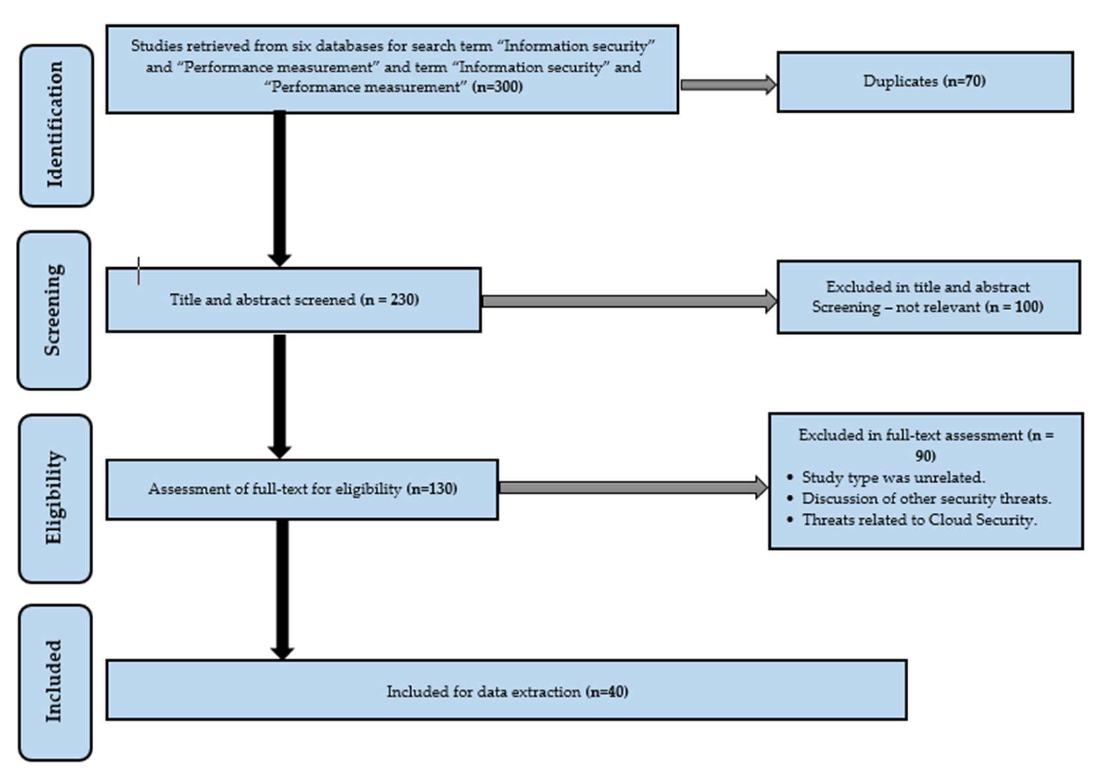
Figure 1. Article selection process.